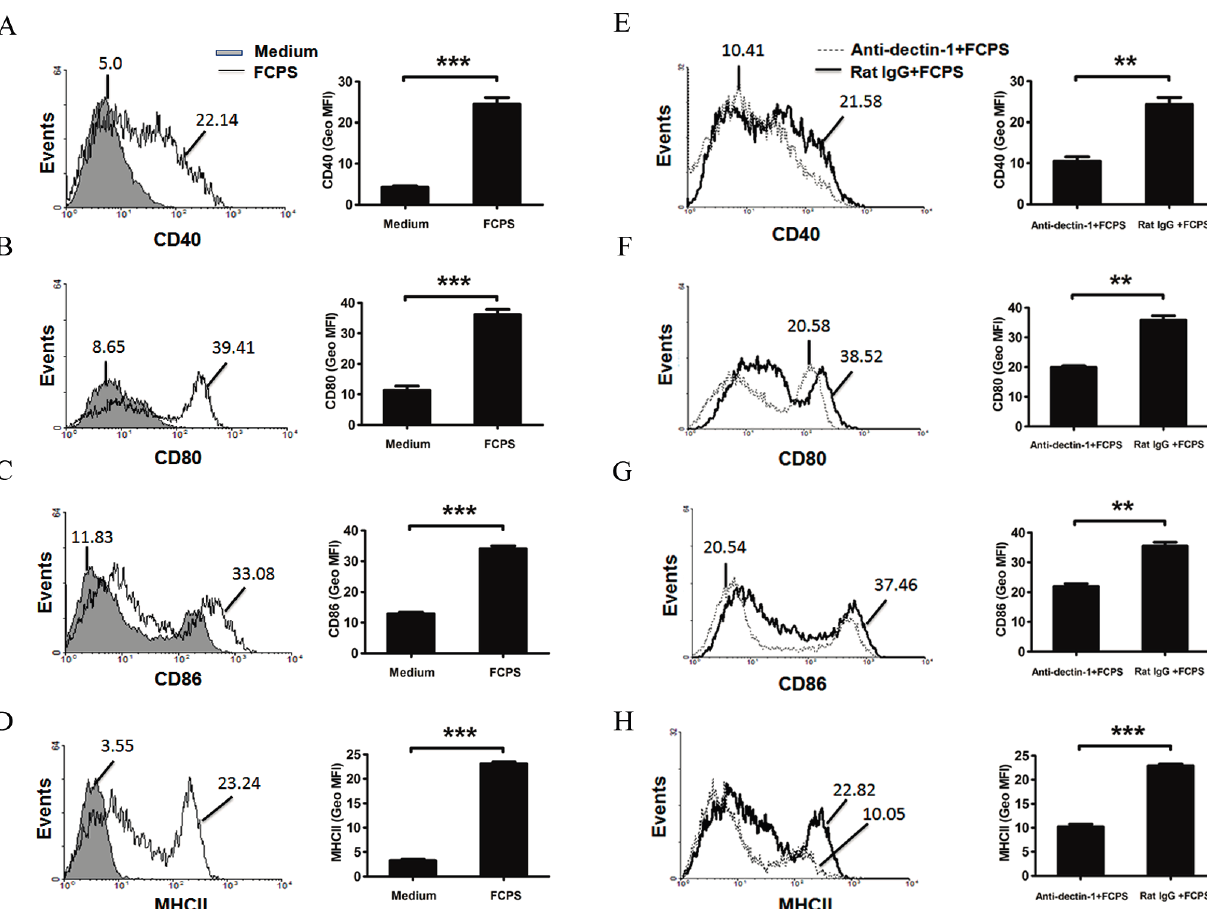
Figure 2. FCPS activate and maturate DC, partially through the dectin-1 pathway. ( A – H ) BMDCs were stimulated with FCPS (100 μ g/mL) with ( E – H ) or without ( A – D ) anti-dectin-1 antibody or ratIgG (5 μ g/mL) for 48 h. Cells were stained with specific Abs against CD40, CD80, CD86, and MHCII, and then analyzed via flow cytometry. The values shown in the histograms are geometric mean fluorescence intensities (GeoMFI). Results are shown as means ± SD from three independent experiments. *** p < 0.001, ** p <